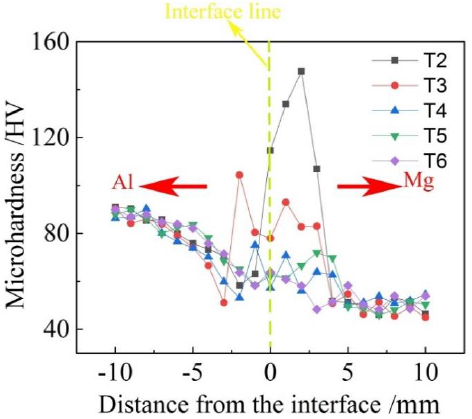
Figure 7. Microhardness distribution of the joints with different tool offset.